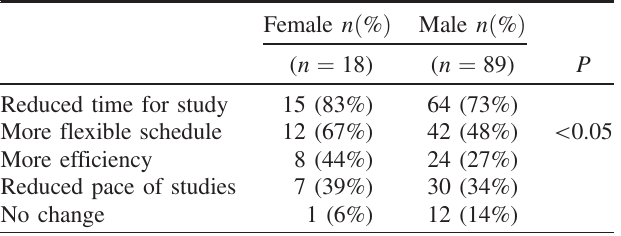
TABLE IV. Results of survey for the following question: How did your course of study change as a